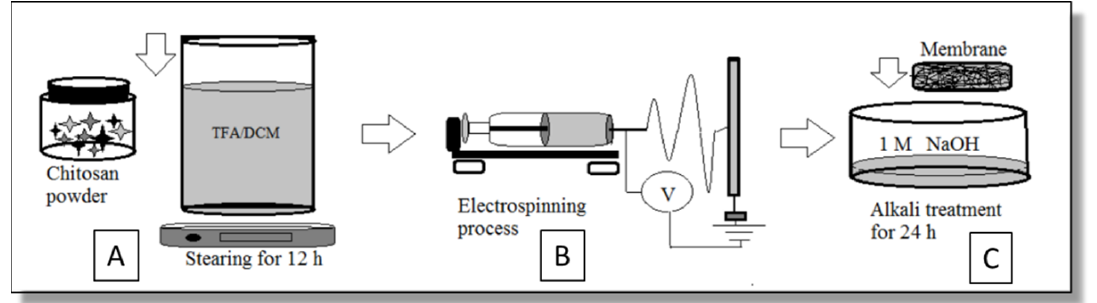
Figure 9. Schematics of sample preparation: ( A ) chitosan solution preparation; ( B ) electrospinning process; ( C ) alkali treatment of chitosan membrane.